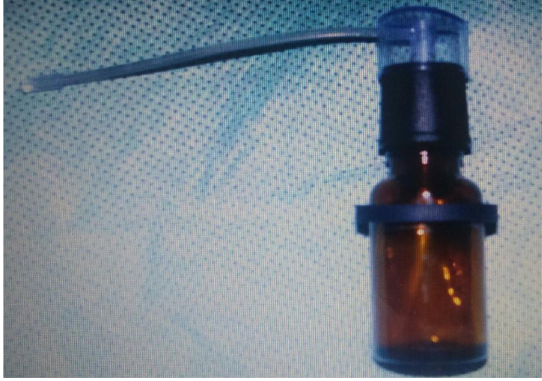
Figure 1 Atomizer used for drug